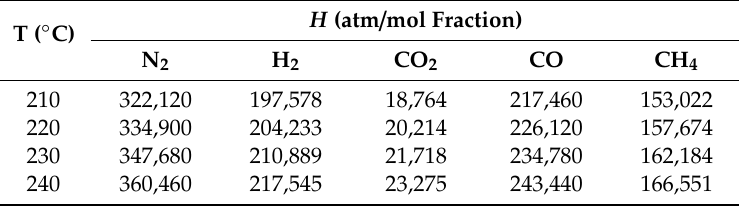
Table 3. Extrapolated Henry’s law constants H for gases at the di ff erent operating temperatures. H (atm / mol Fraction) T ( ◦ C) N 2 H 2 CO 2 CO CH 4 210